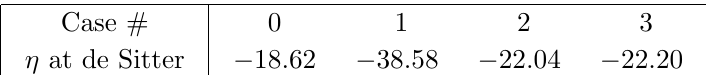
Table 2 . Values of the (cid:17) -parameter for all cases at the de Sitter saddle